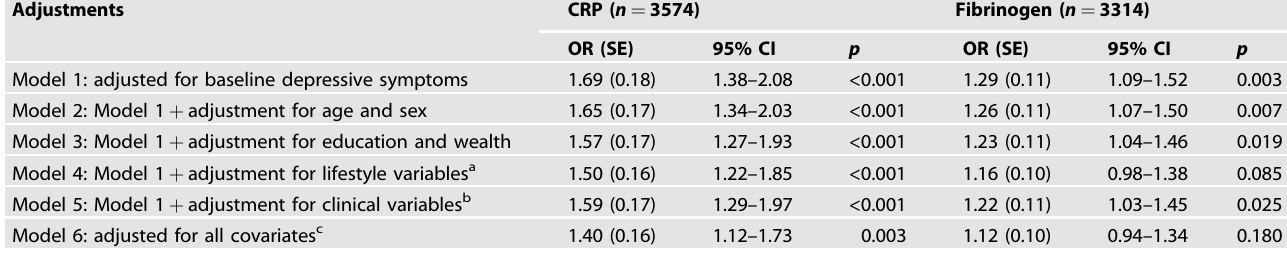
Table 2. Longitudinal associations between pre-pandemic in fl ammatory markers and depressive symptoms during the pandemic.